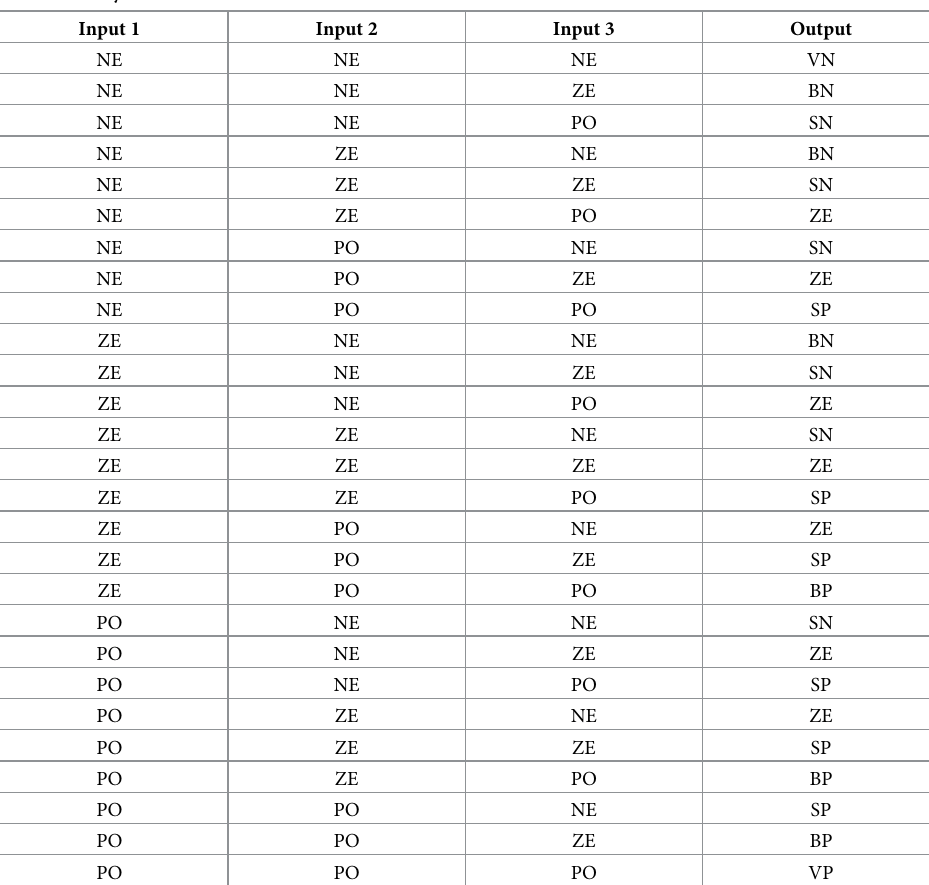
Table 1. Fuzzy rules.